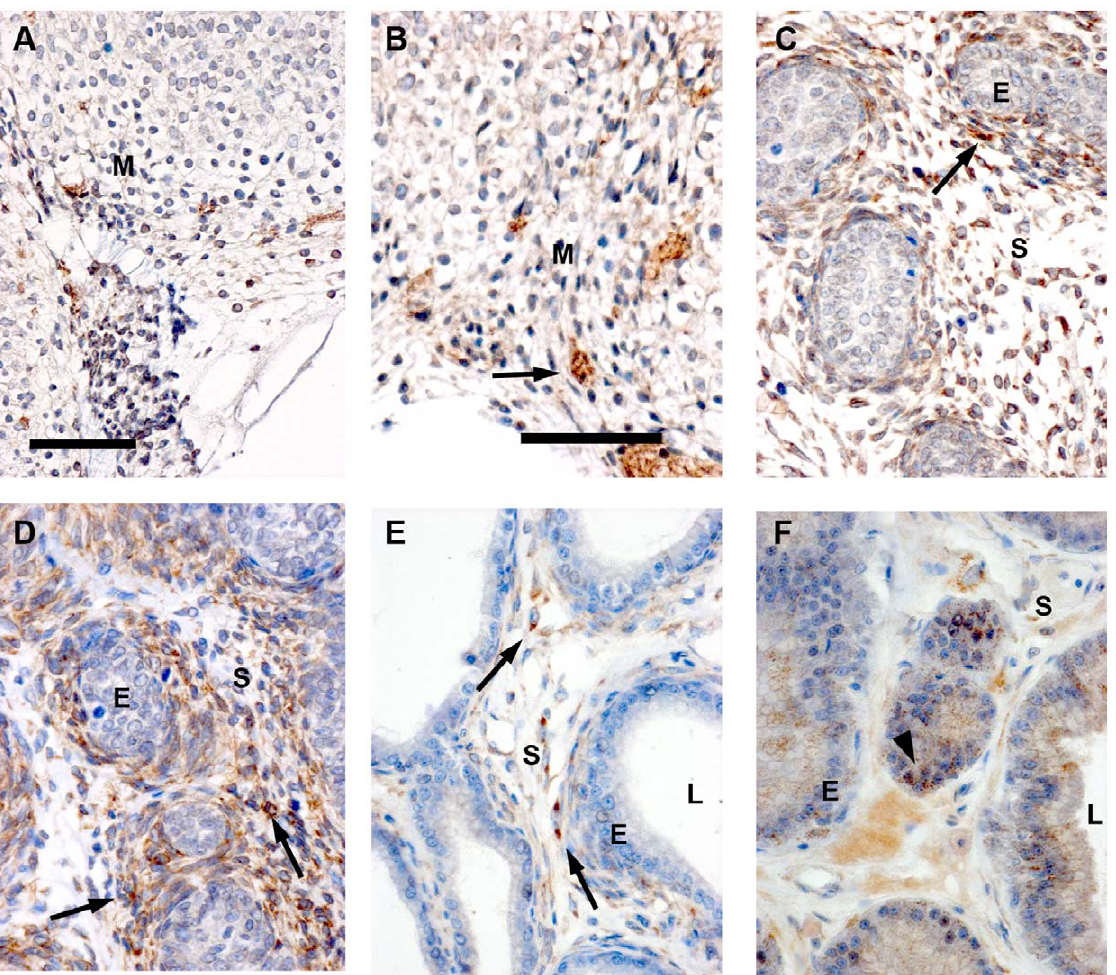
Figure 3. Immunolocalisation of Tsukushi in the developing rat prostate. Developmental stages of E17.5 (A), E19.5 (B), P0.5 (C), P6.5 (D), P28 (E) and young adult VP (F) were investigated. At developmental stages E17.5, E19.5 the magnifications show the areas of prospective VP, while at P0.5 and P6.5 it is either the VP or the DP. Tsku protein expression was mesenchymal/stromal only until P28 (arrows). However, in adult VP, there was additional low expression in the epithelium (arrowhead in F). Interestingly, smooth muscle cells were also positive for Tsku (P0.5 to P28). Scale bars equal 200 m m.